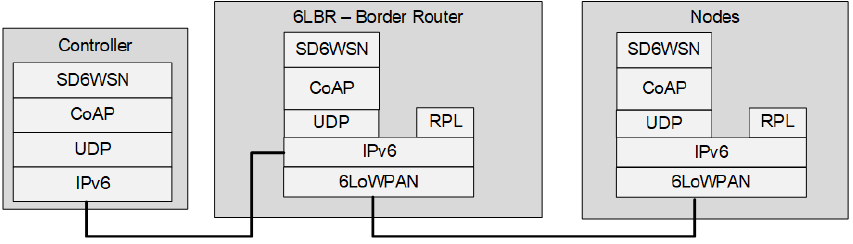
Figure 2. Communication between SD6WSN